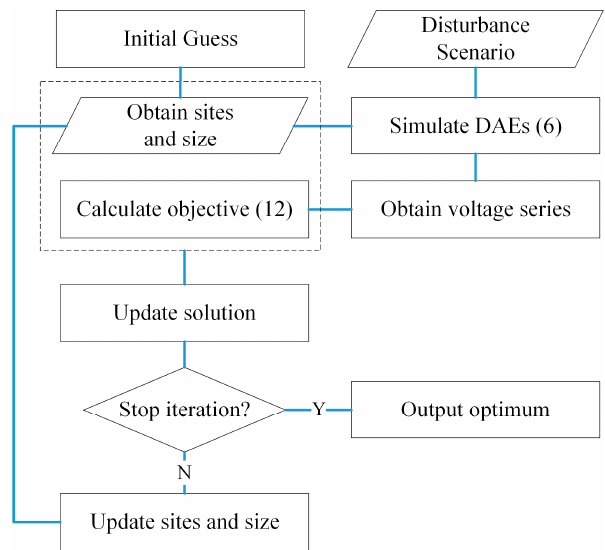
Figure 4. Flowchart of the proposed method.